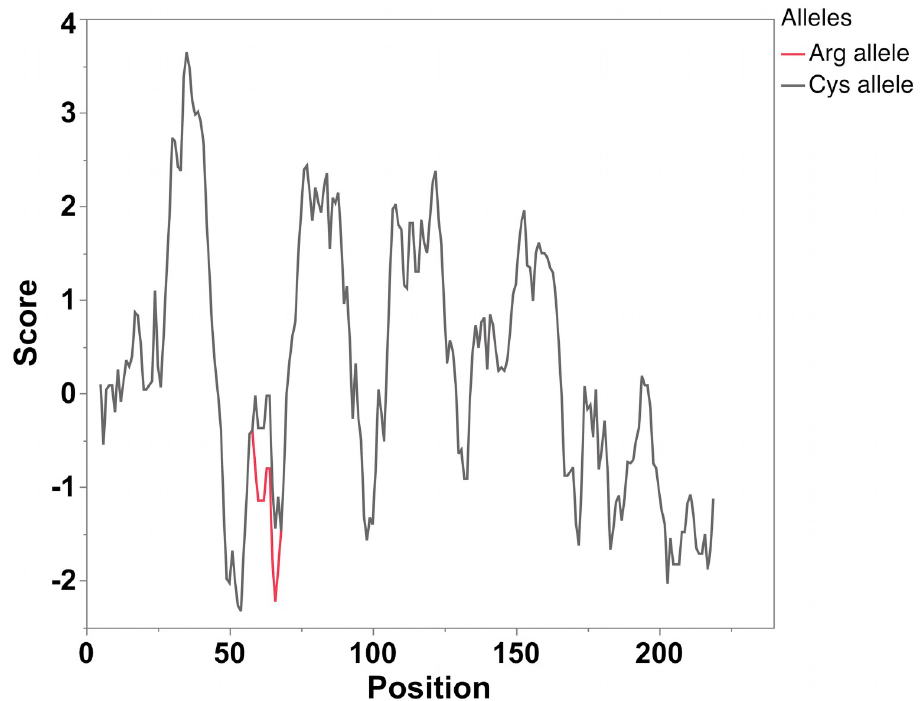
Fig 5. Hydrophobicity profile of the SYNGR2 Arg63Cys polypeptides based on the Kyte and Doolittle scale (the window consisted of 9 amino acid residues). An increase in the hydrophobicity score was observed in the predicted SYNGR2 p . 63Cys